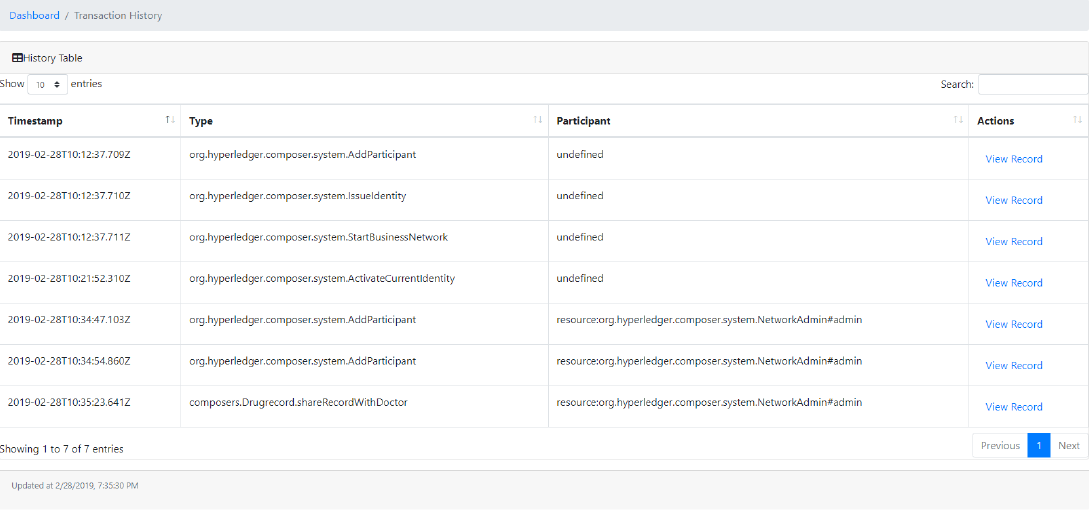
Figure 24. Transaction